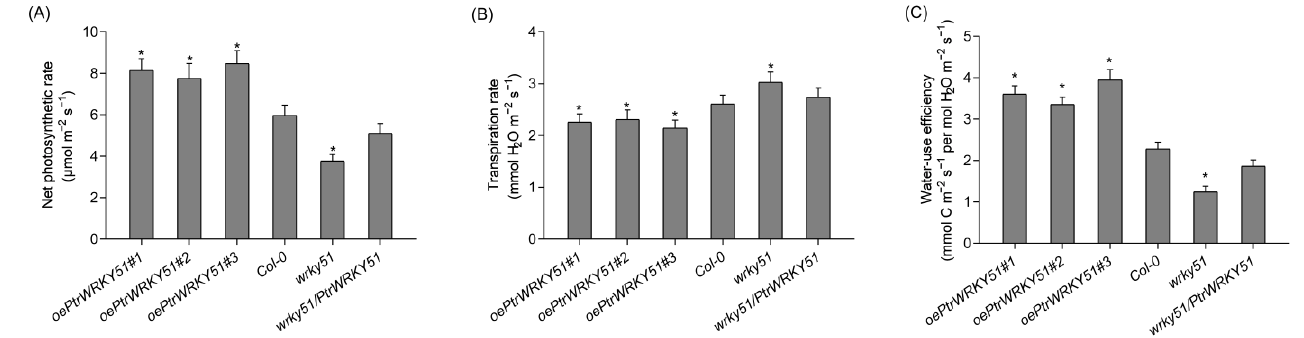
Figure 4. Gas exchange analysis of overexpressing PtrWRKY51 lines showing higher instantaneous WUE in Arabidopsis . The Net photosynthesis rate ( A ), transpiration rate ( B ), instantaneous leaf WUE ( C ) of 3-week-old seedlings. The data are represented as means ± SE ( n = 12). The asterisks (*) represent significant differences (* p < 0.05) compared to the control.